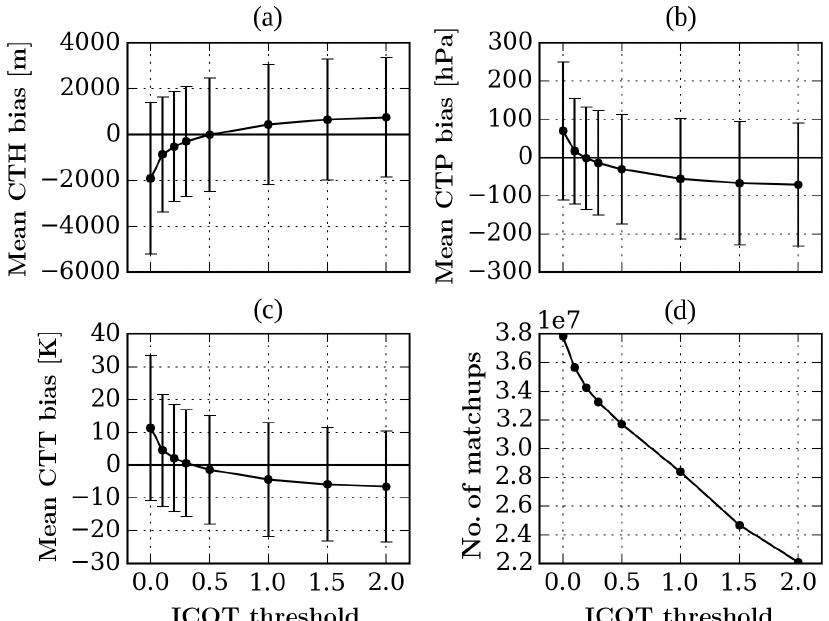
Figure 4. Mean biases (CLAAS-2–CALIOP) of CTH (a) , CTP (b) and CTT (c) compared against the CALIOP cloud layer at which ICOT exceeds a certain threshold. The error bars represent the bc-RMSE. The number of collocated measurements is also shown (d) .